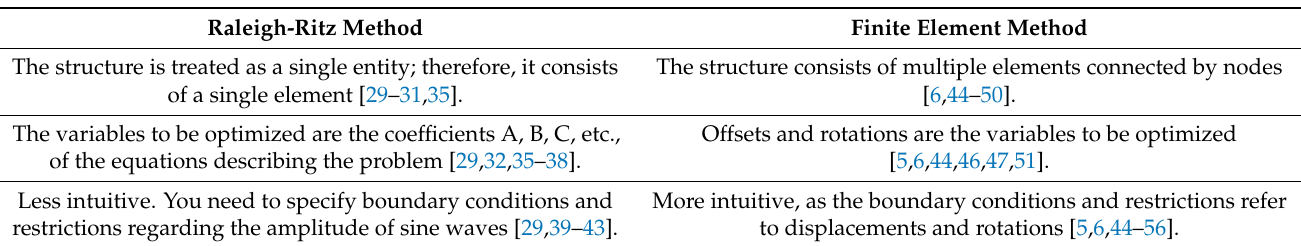
Table 2. Comparative chart for material analysis methods.